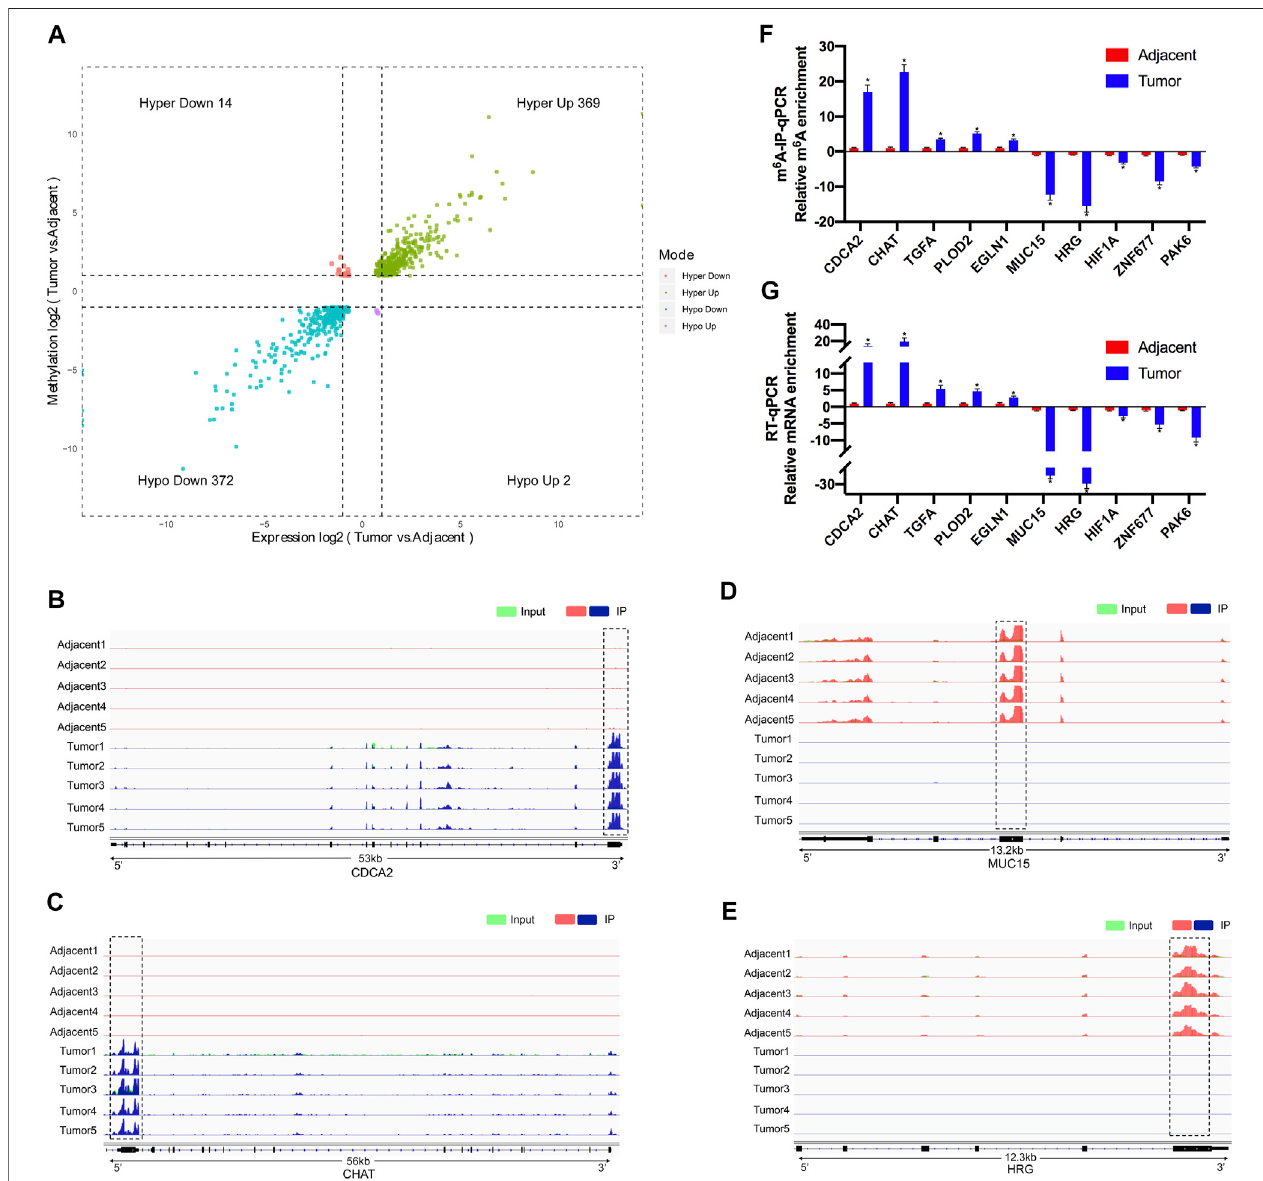
FIGURE 5 | Conjoint analysis of differentially methylated genes and differentially expressed genes between fi ve paired renal tumor and adjacent tissues. (A) Four quadrant diagram showing the differentially methylated genes and differentially expressed genes. (B,C) Integrative Genome Viewer (IGV) software showing the m 6 A peaks in hypermethylated and upregulated gene cell division cycle-associated 2 (CDCA2) (B) and choline-O-acetyltransferase (CHAT) (C) . (D,E) Integrative Genome Viewer (IGV) software showed the m 6 A peaks in hypomethylated and downregulated genes mucin 15 (MUC15) (D) and histidine-rich glycoprotein (HRG) (E) . (F) Validations of the m 6 A enrichment of fi ve hypermethylated genes (CDCA2, CHAT, TGFA, PLOD2, and EGLN1) and fi ve hypomethylated genes (MUC15, HRG, HIF1A, ZNF677, and PAK6) by m 6 A-immunoprecipitation (IP)-qPCR ( n (cid:1) 5). (G) Validations of the mRNA expression level of fi ve upregulated genes (CDCA2, CHAT, TGFA, PLOD2, and EGLN1) and fi ve downregulated genes (MUC15, HRG, HIF1A, ZNF677, and PAK6) by RT-qPCR ( n (cid:1) 5). * p <